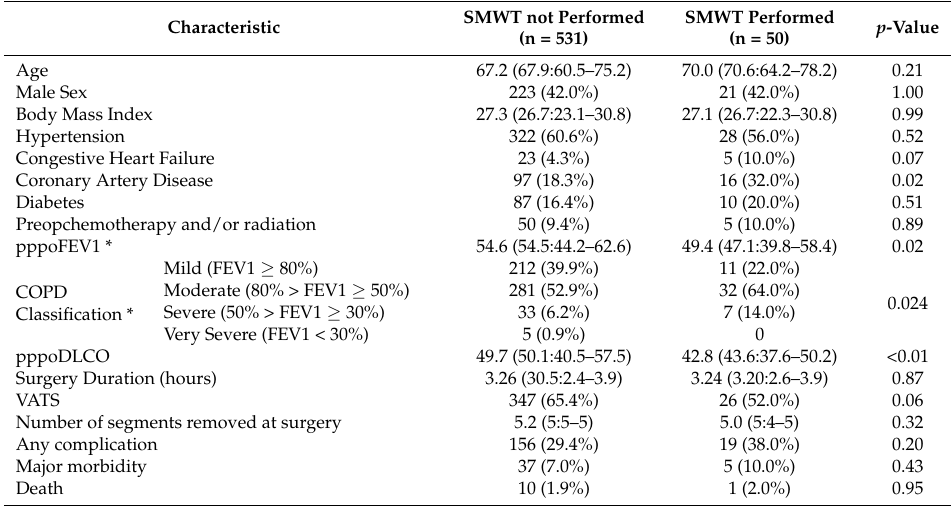
Table 1. Characteristics of patients with pppoFEV1 or pppoDLCO ≤ 60% subdivided by whether they received six-minute walk testing. Data presented as mean (median:IQR) or N (%). Comparison using two tailed t -test or chi squared.